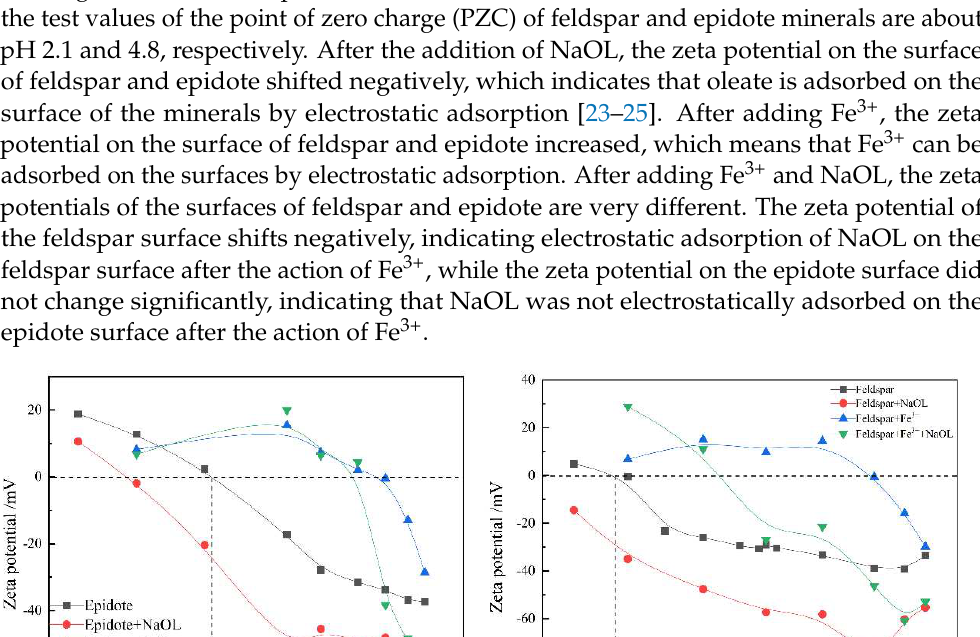
Figure 5. Species distribution diagrams of NaOL ( a ) and Fe 3+ ( b ) in solution as a function of pH.